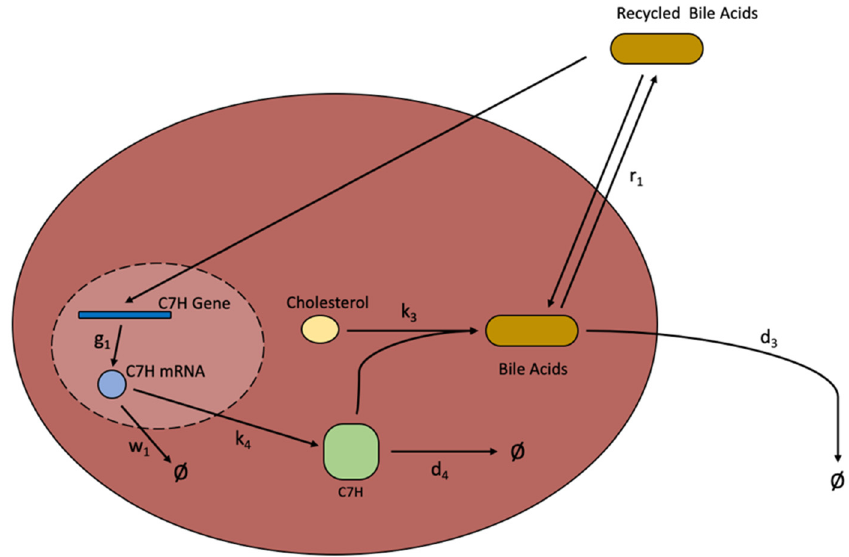
Figure 4. Bile acid synthesis model (Model 6). The rate limiting enzyme for the conversion of cholesterol to bile acids is C7H. The production of C7H is regulated by recycled bile acids. Bile acids can either be recycled (~95%) or expelled from the body (~5%). Equations of Model 6 are shown in A38 through A44 in Appendix A [22,26].